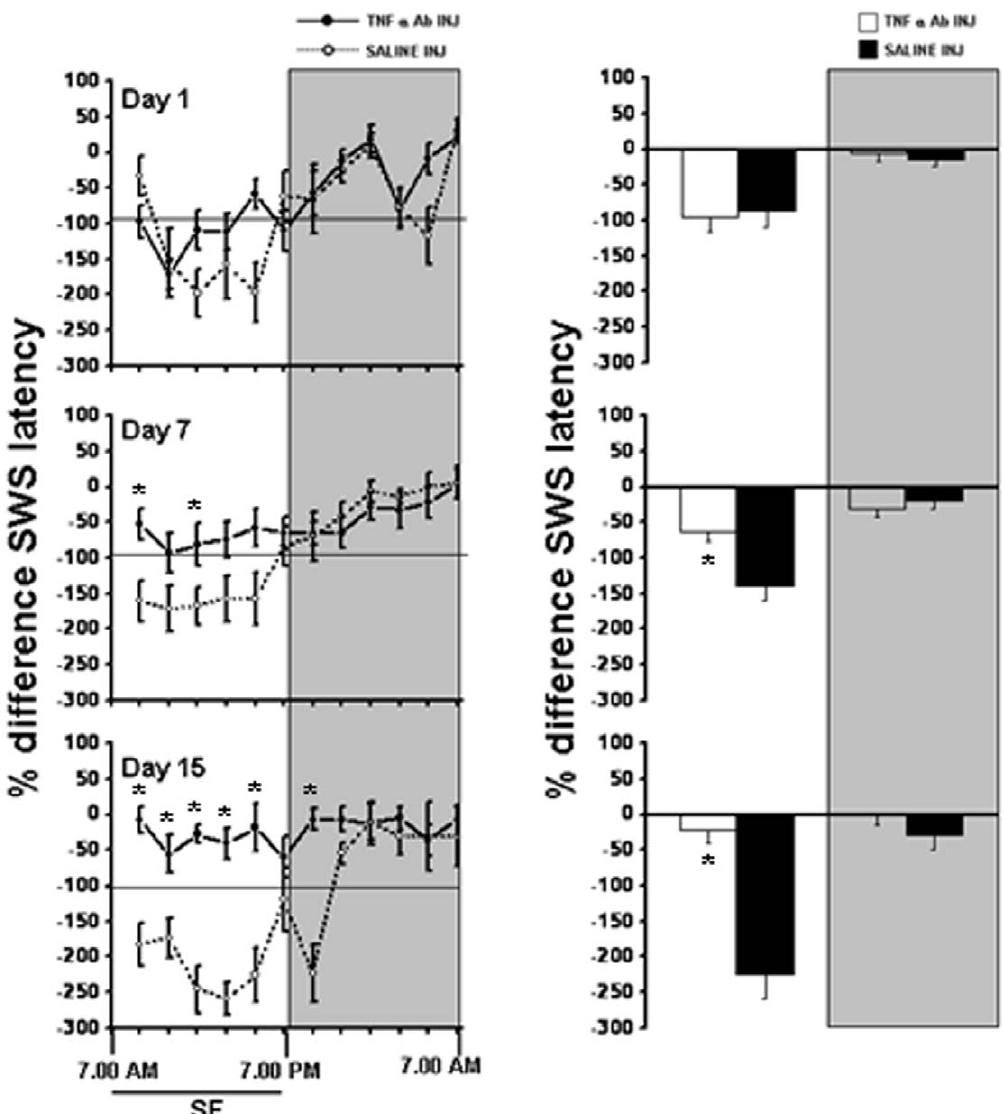
Figure 7. SWS sleep latency in saline and TNF- a antibody injection mice. Left panel shows percent differences in SWS latency in TNF- a antibody injection (solid line) and saline injection (dashed line) (2 hr bins) group on day 1, day 7 and day 15 of SF. Right panel shows total SWS latency during light period and dark period in TNF- a antibody injection (open bars) and saline injection (filled bars) mice. Shaded area represent dark period. The black line indicates SF period (7.00 am to 7.00 pm). SF, sleep fragmentation. p , 0.05. *=comparison between TNF- a antibody injection and saline injection mice during respective post-fragmented days.